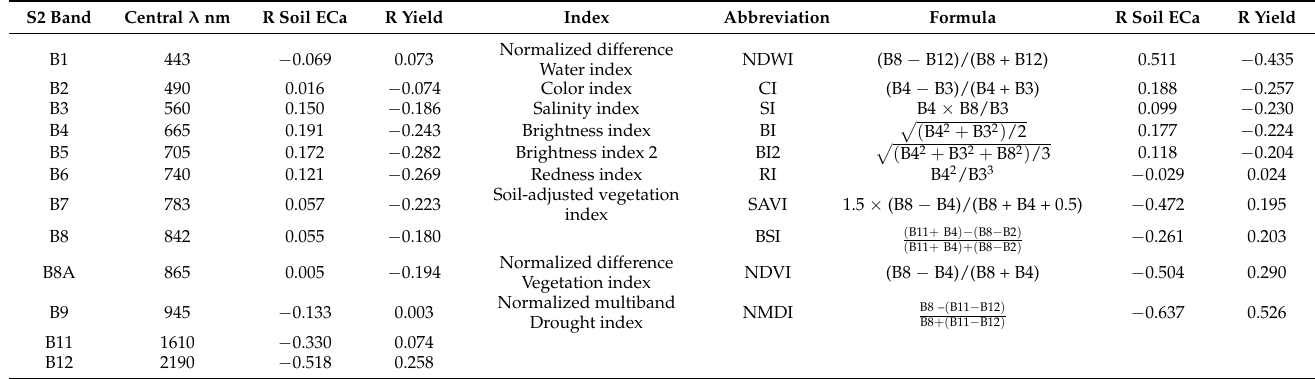
Table 1. Correlation coefficients (R) between reflectance of Sentinel-2 bands as well as several indices with soil ECa and final